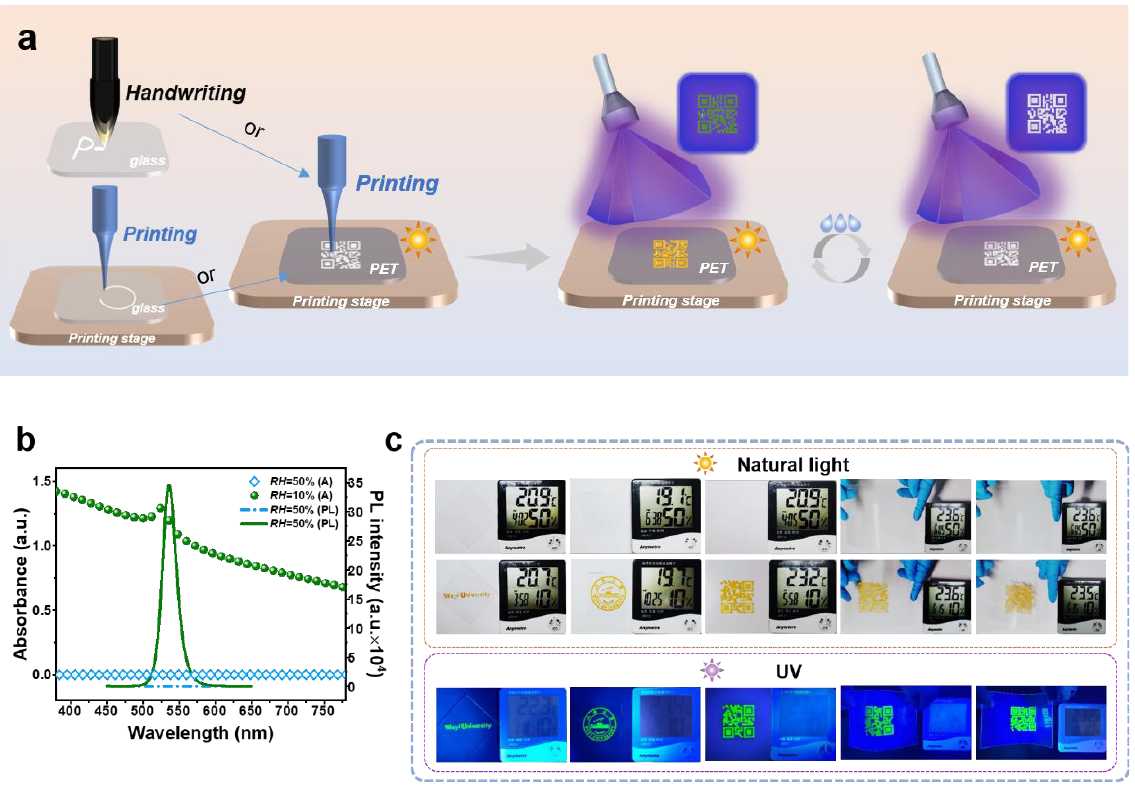
Figure 4. Application of PPC in dual sensing of temperature and humidity. ( a ) Schematic drawing of reversible fluorescent patterns on glass substrates and PET substrates by handwriting or printing. ( b ) UV-vis and PL spectra at different RH. ( c ) Humidity-sensitive words and patterns from PPC materials were designed via printing and writing on glass slides and flexible PET substrates.